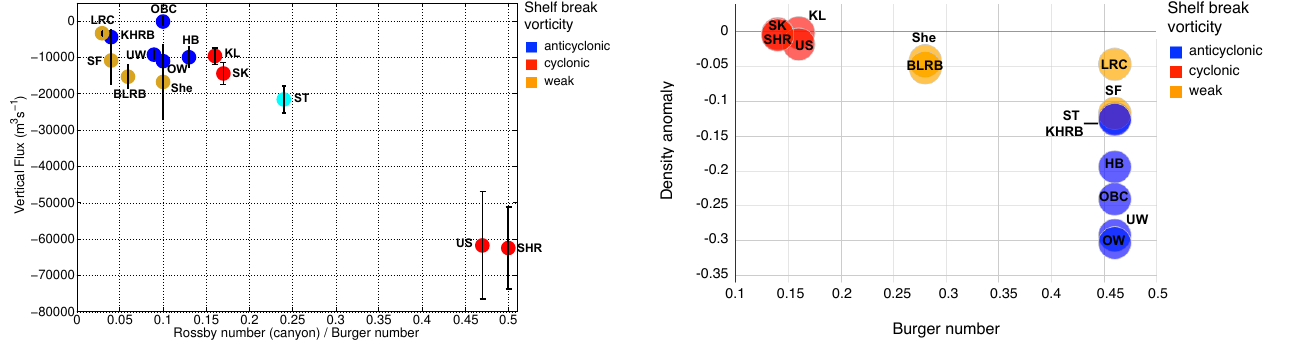
Figure 15. Burger and canyon Rossby number effect on vertical flux at shelf break depth (150m). Due to complex canyon topography, canyon Rossby number for ST is likely overestimated and ST is considered an outlier.